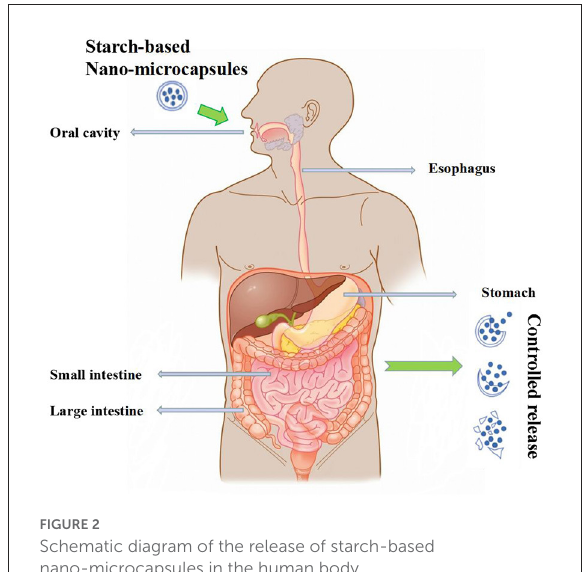
FIGURE2 Schematic diagram of the release of starch-based nano-microcapsules in the human